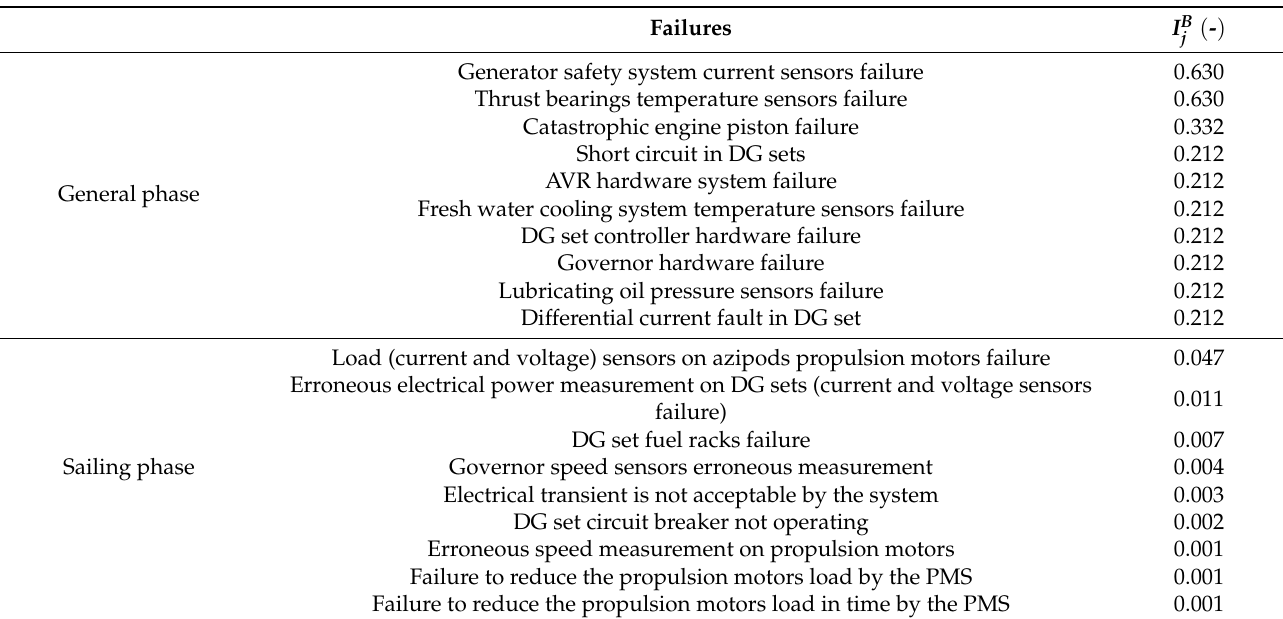
Table 9. Calculated I B indicating the system’s top sensitive j